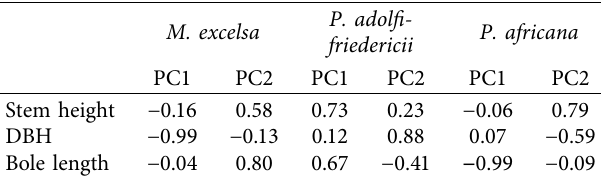
Figure 5: Hierarchical clustering of the populations of P. africana based on one scaled morphometric data using “Euclidean” distance and “wards D2” method. KNF � Kahoshemeta natural forest, KS2NF � Kafa–Shera 2 natural forest, MGF � Masha-Gorashewi forest, Table 2: Principal component analysis (PCA) showing the efect of morphometric in clustering the populations of M. excelsa, P. adolf- friedericii, and P. africana measured at the diferent